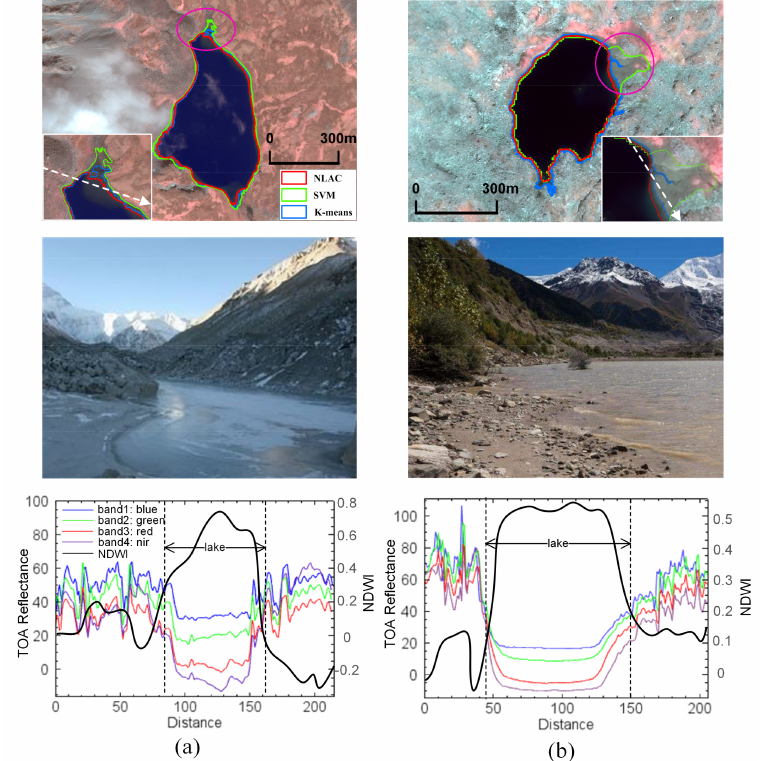
Figure 9. Experimental results showing comparison between the proposed method and conventional classification methods for different heterogeneous environments: ( a ) Glacial lake surrounded by clay, wet muddy soil, and ripples, etc.; ( b ) Lake surrounded by aquatic vegetation with high moisture content. The figures in the first row show the final shorelines overlaid on the FCC image. The insets show zoomed out views of the area marked by the magenta ellipses. The second row consists of field photographs taken in the same area. The third row shows profiles of the NDWI and surface reflectance. The location of the profiles is indicated by the white dotted arrows in the insets in the first